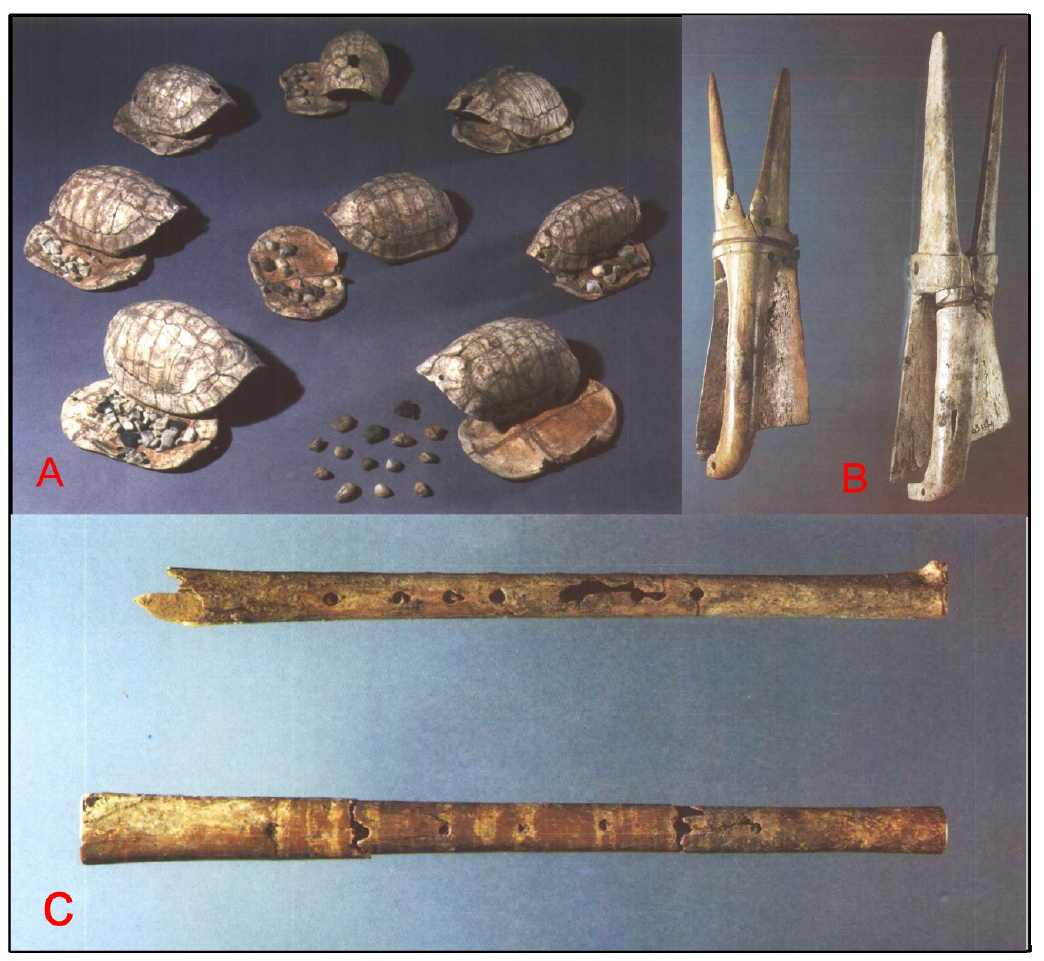
Figure 4. The items possibly used as ritual paraphernalia in the Jiahu site (( A) turtle shell with gravel, found in burial M363; ( B) bone folk-shaped item; 1 : found in burial M395, 2 : found in burial M363. ( C) bone flute; 1 : found in burial M57, 2 : found in burial M68; after [47])).